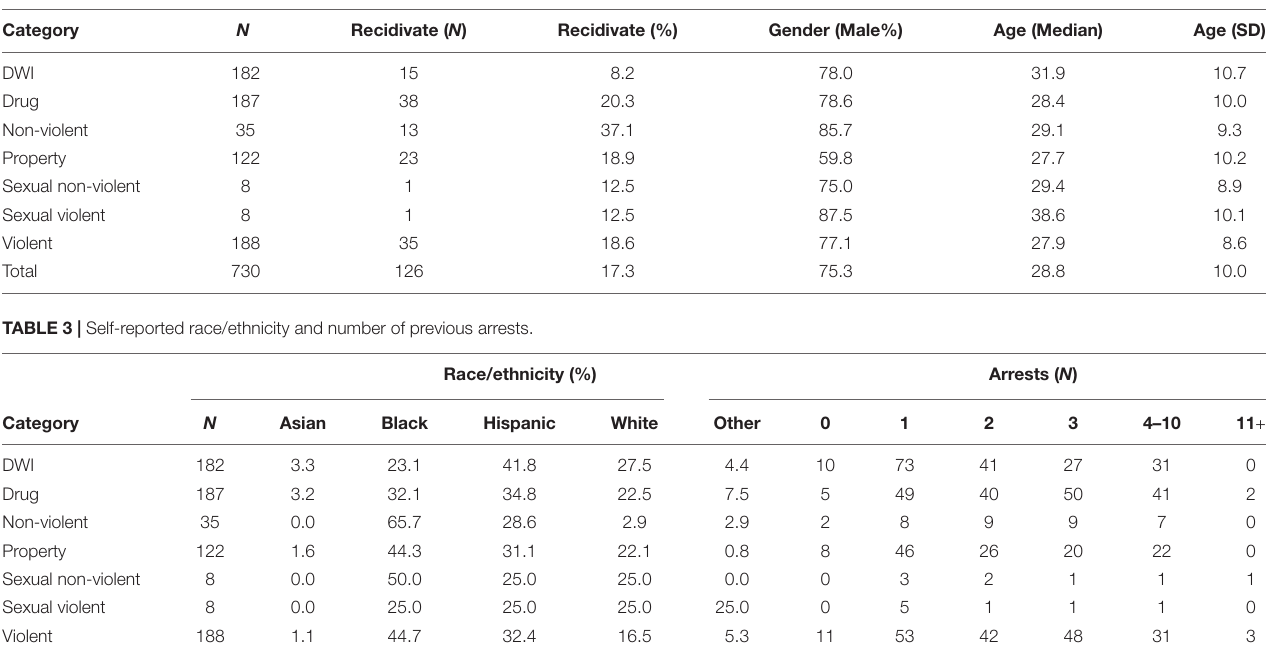
TABLE 2 | Overview of probationers (age and gender) and recidivism, by current offense category. Category